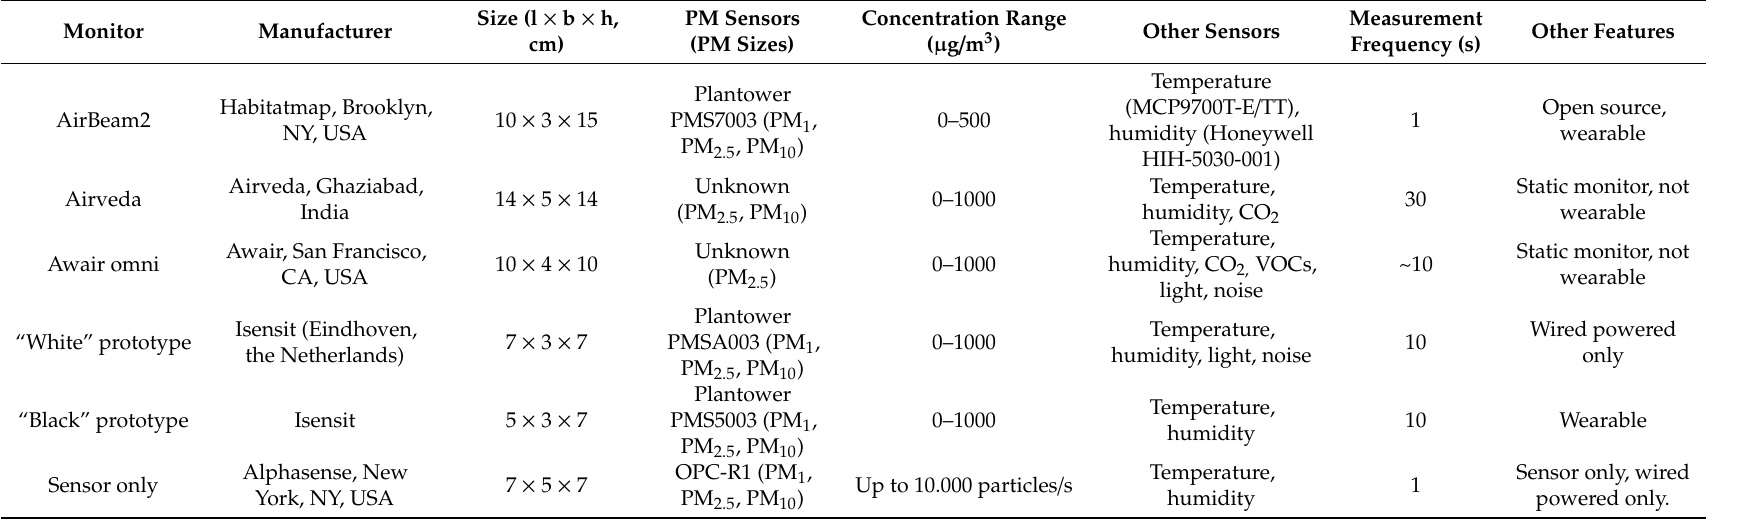
Table 3. Technical specifications of monitors